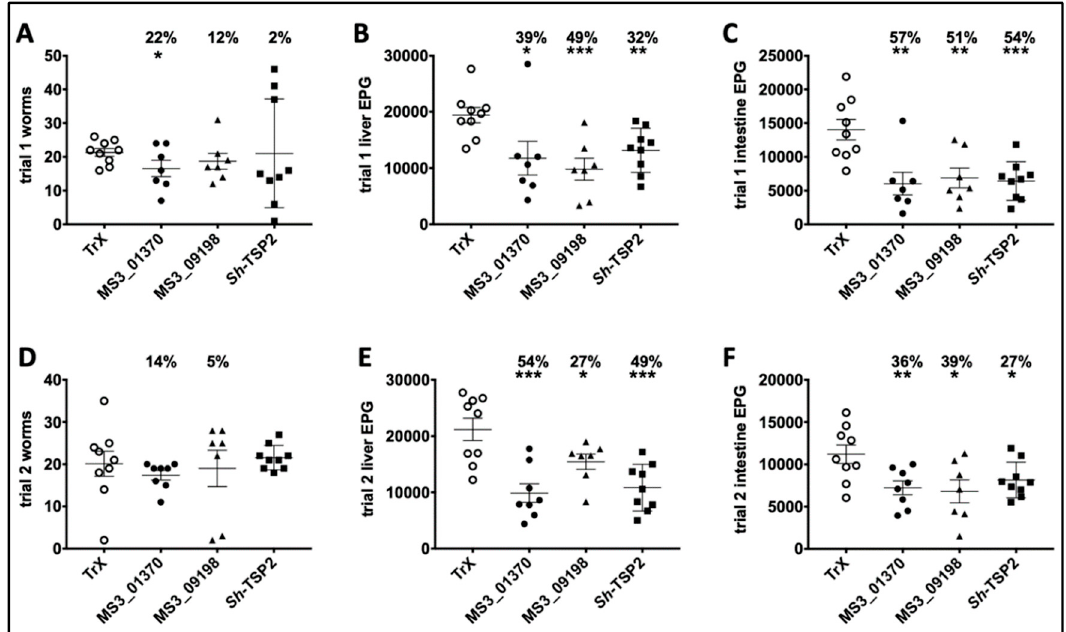
Figure 4. Schistosoma mansoni worm and egg burden reduction of vaccinated and control mice vaccinated with S. haematobium recombinant tetraspanins. ( A ) Adult worm reduction trial 1, ( B ) liver egg reduction trial 1, ( C ) intestinal egg reduction trial 1, ( D ) Adult worm reduction trial 2, ( E ) liver egg reduction trial 2, and ( F ) intestinal egg reduction trial 2. The percentage of reductions in parasite burden are above each dataset. Differences between each vaccinated group and the control group were analyzed with a student’s t-test. * p < 0.05, ** p < 0.01, *** p < 0.001.